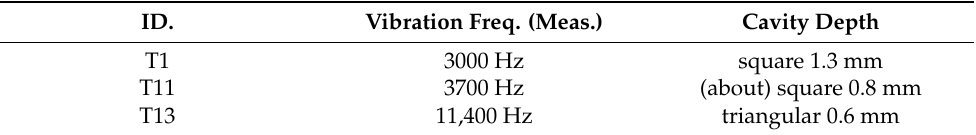
Table 3. Characteristic frequency of the vibration velocity peaks, revealed in the central point of the cavity on the tile